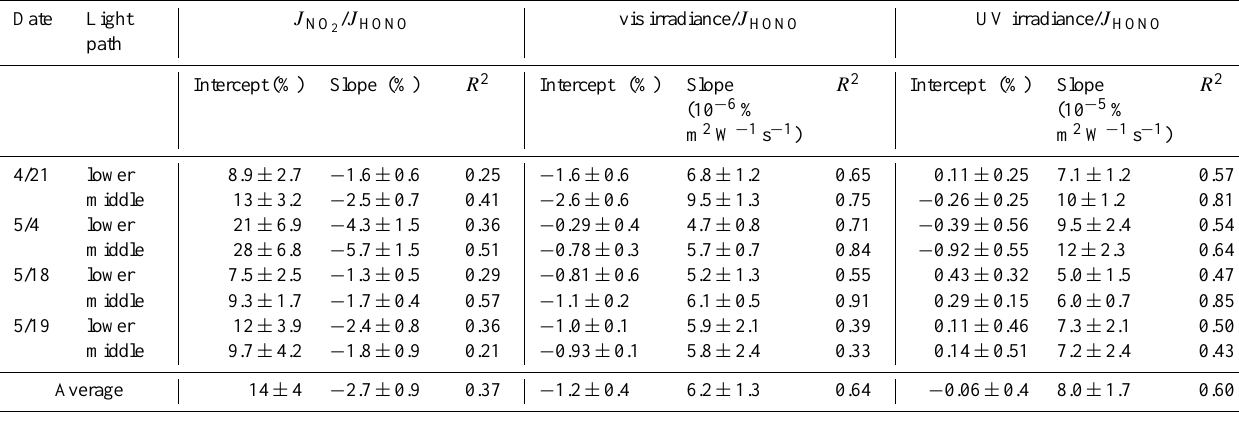
Fig. 10. Correlations of the adjusted HONO to NO 2 ratios with J NO days (21 April, 4, 18 and 19 May) during SHARP 2009. Table 2. Linear fit results of Fig.